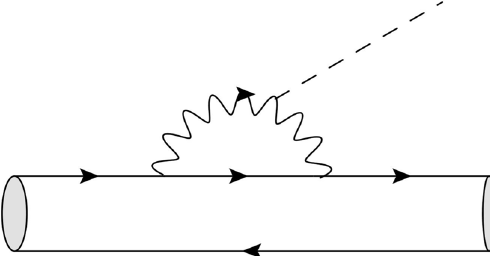
Fig. 3 One-loop penguin contributions